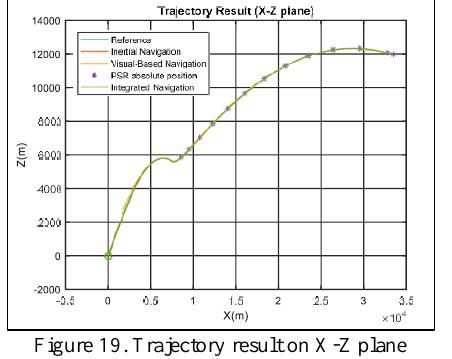
Figure 19. Trajectory result on X-Z plane